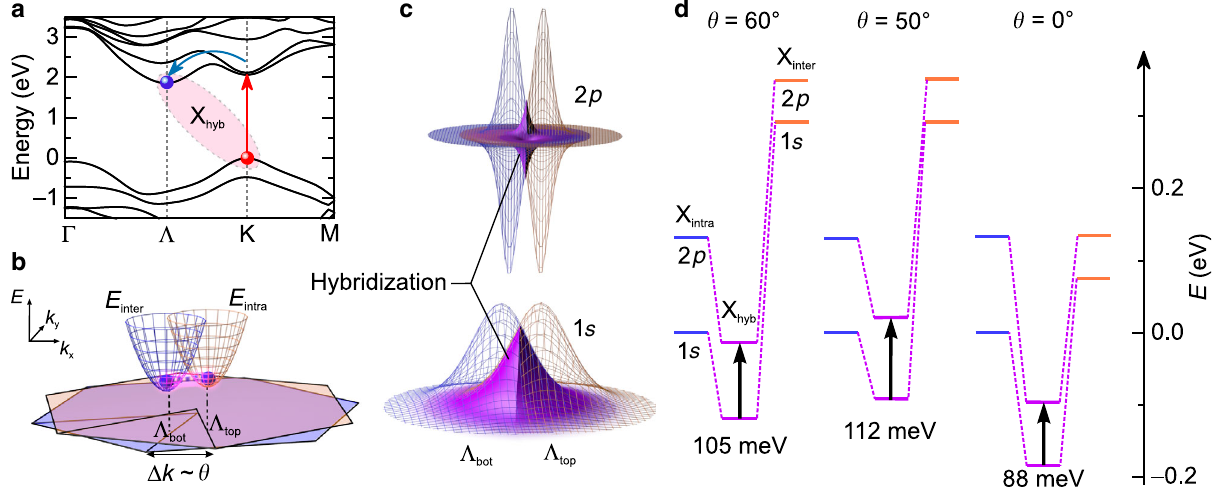
Fig. 3 Hybridization between intra- and interlayer excitons. a Single-particle band structure of the WSe 2 BLs for θ = 60°, calculated by density functional theory (see Methods). After resonant excitation (red arrow) at the K point, electrons scatter via phonons (blue arrow) into the energetically favorable Λ valley to form hybrid excitons (X hyb ). b Within the microscopic model, the electron is located in a Λ -like valley of the top ( Λ top ) or bottom ( Λ bot ) layer for a fi nite crystallographic misalignment. The parabolic dispersion of intra- ( E E intra ) and interlayer ( inter ) excitons is shifted in momentum space by twisting the layers, owing to the momentum mismatch Δ k between Λ top and Λ bot . Strong interlayer wavefunction overlap promotes electron hopping and exciton hybridization (pink glow). c The overlap (violet surface) of excitonic wavefunctions (blue and orange grids) in momentum space depends on Δ k . For clarity, we only show the real part of the exciton wavefunctions. d Hybridization of 1 s and 2 p excitons lowers the energy levels (magenta lines) with respect to the corresponding non-hybridized states X intra and X inter (blue/orange lines). The situation is sketched for θ = 60°, θ = 50°, and θ = 0°. Zero energy is set to the non-hybridized 1 s state at θ = 60°. The vertical black arrows mark respective 1 s – 2 p transition